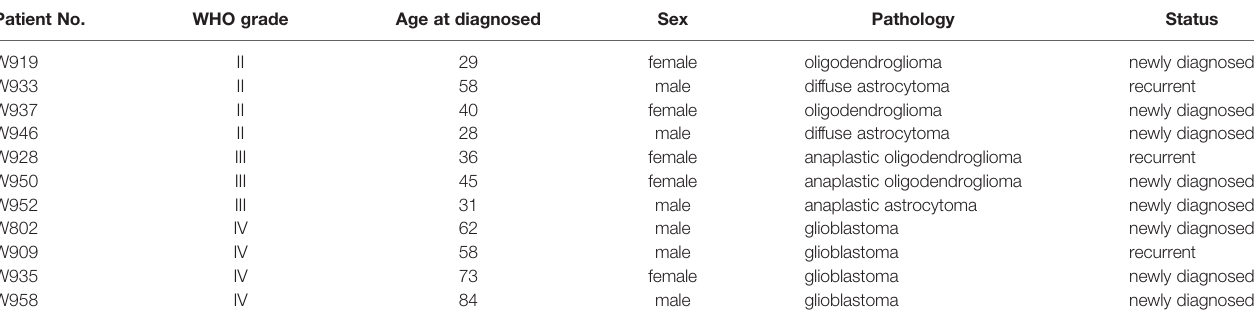
TABLE 1 | The information of patients who received brain tumor resection in Linkou Chang Gung Memorial Hospital from Feb. 2014 to Jul. 2015. Patient